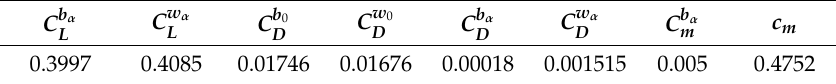
Table 2. Body and wing critical parameters [Speed = 0.52 kts, R e = 10 4 and α att = 3.3 ◦ ].